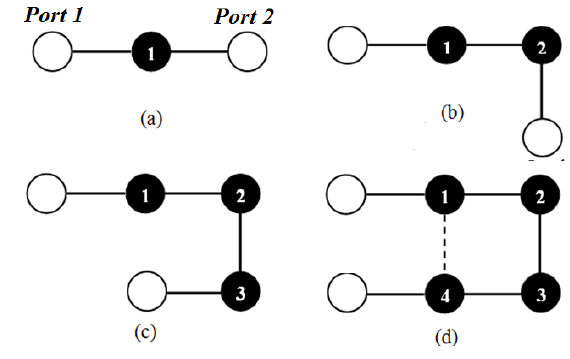
FIGURE 2. The four stages (a-d) of filter topology tuning